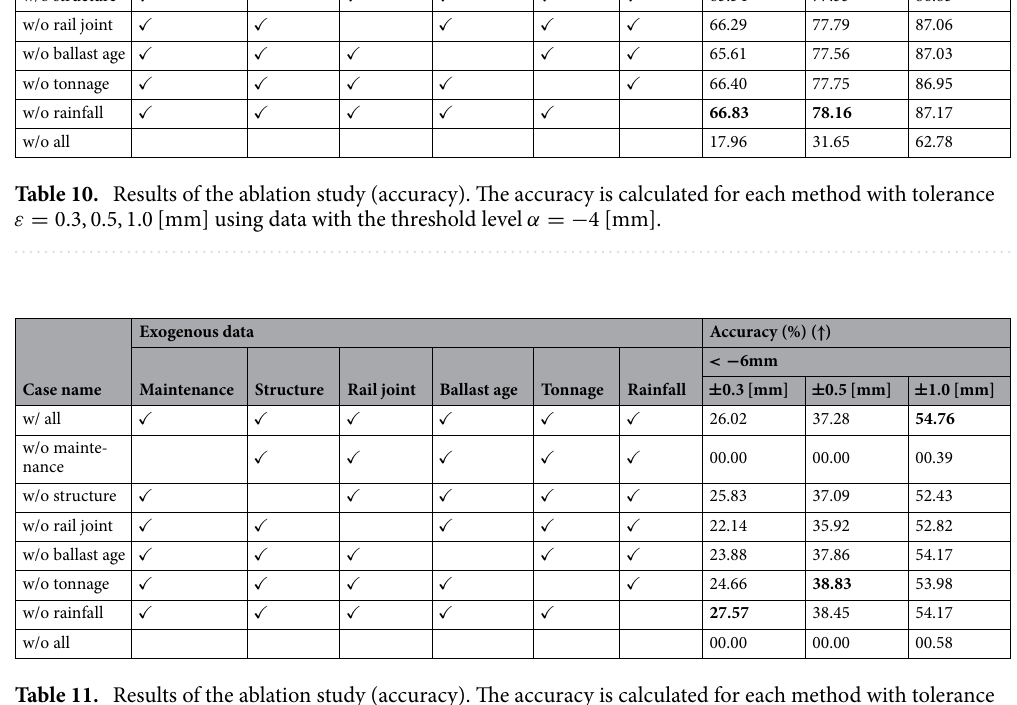
Table 11. Results of the ablation study (accuracy). The accuracy is calculated for each method with tolerance ε = 0.3, 0.5, 1.0 [mm] using the data with threshold level α = − 6 [mm].